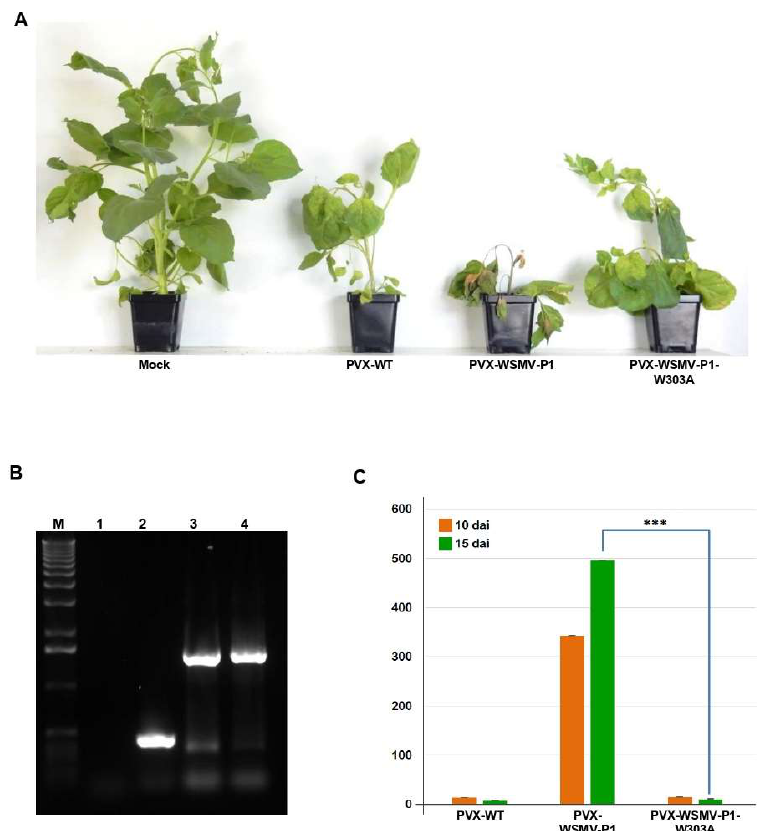
Figure 6. GW motif in WSMV P1 is required for pathogenicity enhancement of Potato virus X (PVX) in Nicotiana benthamiana . ( A ) Symptoms elicited by wild-type and chimeric PVX on N. benthamiana at 15 dpi. Note PVX-WSMV-P1 elicited severe symptoms while PVX-WSMV-P1-W303A elicited mild symptoms similar to PVX-WT. ( B ) RT-PCR analysis of total RNA isolated from symptomatic leaves (15 dpi) of N. benthamiana plants inoculated with PVX-WT (lane 2), PVX-WSMV-P1 (lane 3) or PVX-WSMV-P1-W303A (lane 4) with primers flanking the site of insertion. Lane 1: mock-inoculated N. benthamiana . Lane M represents 1.0 kbp DNA size standard. ( C ) Real-time RT-PCR analysis of total RNA extracted from symptomatic N. benthamiana leaves to determine the relative accumulation of PVX. The ∆∆ Ct method was used to determine the relative expression of PVX upon normalization with Nb-Actin as an internal reference. Student’s T -Test was conducted to calculate the most probable differences of PVX relative expression in each biological replicate with 99% confidence represented as ***. Bars on histograms indicate standard